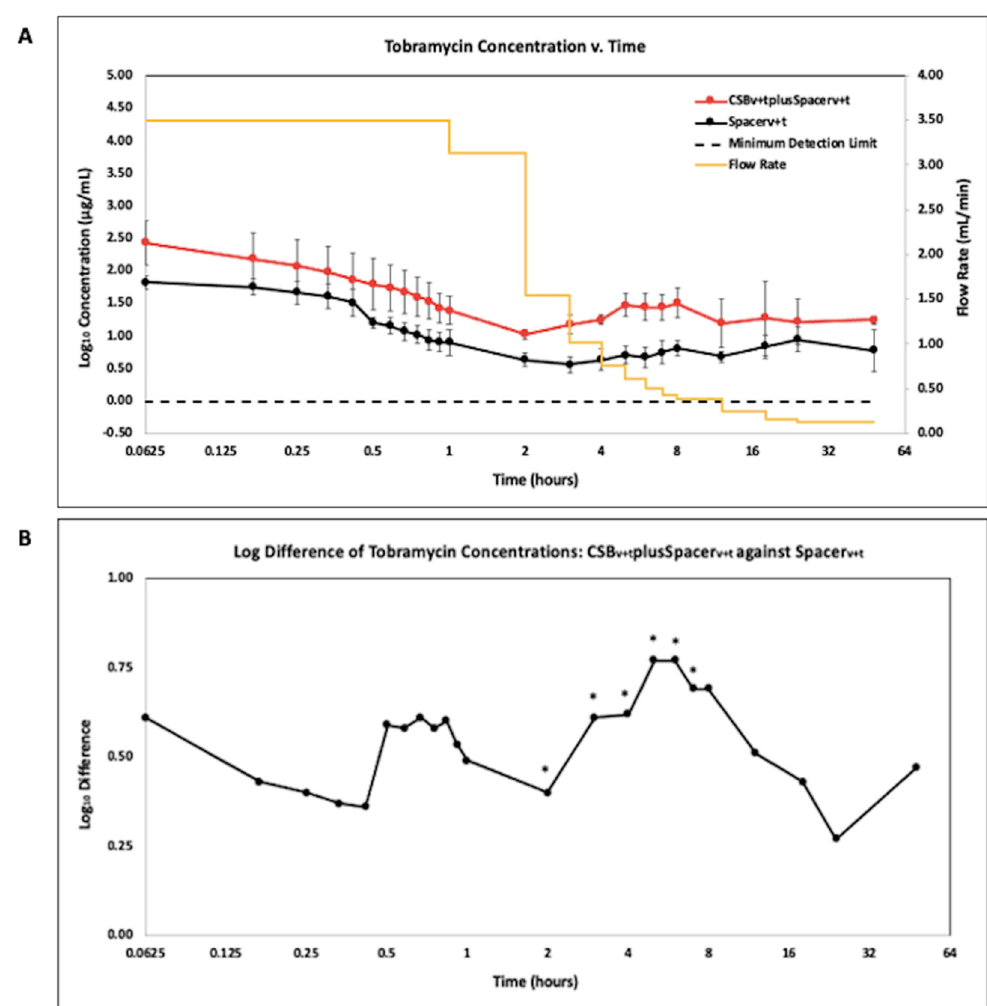
Figure 4. ( A ). LCMS analysis of tobramycin in effluent samples from antibiotic loaded calcium sulfate beads with an antibiotic loaded PMMA spacer (CSB v+t plusSpacer v+t ), and antibiotic loaded PMMA spacer (Spacer v+t ). N = 6; geometric mean ± SE. The yellow curve is the influent saline flow rate. Time is shown on a log2 scale to show the changes more clearly in concentration at the early time points. ( B ). Log difference of tobramycin concentrations of the CSB v+t plusSpacer v+t method compared to the Spacer v+t method. (* p < 0.05).